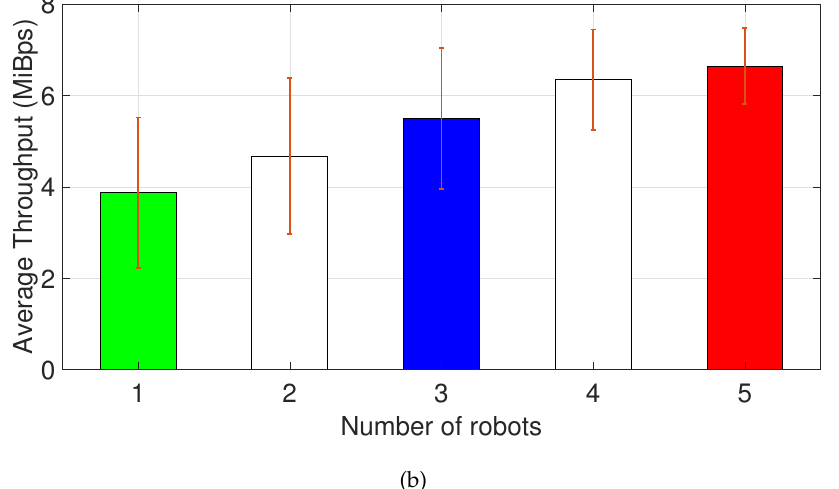
Figure 6. Throughput evolution for an up to five parallel robots scenario: ( a ) One minute throughput curve. ( b ) Average rate plus standard deviation. Dashed lines stand for raw data, while solid lines represent the moving average.